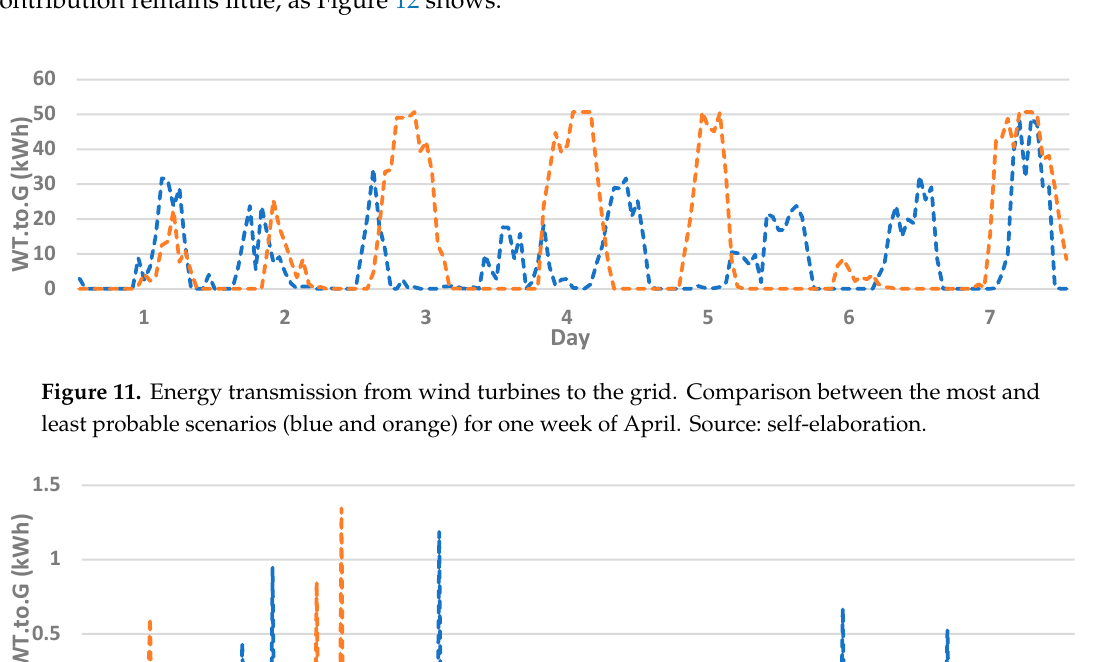
Figure 10. Energy transmission from the wind turbines to the battery bank. Comparison between the most and least probable scenarios (blue and orange) for one week (April). Source: self-elaboration. The sizing results lead the rated power of the wind systems to reach its upper limit; as a result, the wind system is able not only to charge the energy system but to sell the rest of the energy to the grid. As it is depicted in Figure 11, the energy management system forces the wind system to inject the surplus of energy to the grid in the night, when the lowest consumption happens while the wind speed is the highest. However, as PV and batteries have priority at supplying the loads, wind turbines’ contribution remains little, as Figure 12 shows.